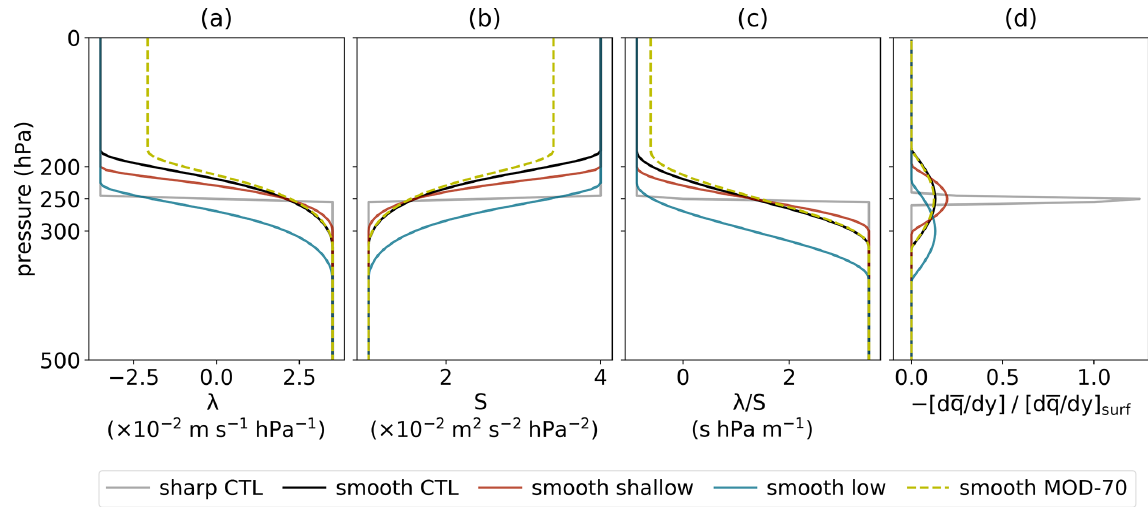
Figure 1. Vertical profiles of λ , S , λ/S , and ∂q/∂y near the tropopause for the sharp and smooth control experiments (grey and black, respectively) contrasted with experiments featuring a smooth shallow tropopause with δ = 100hPa (red), a smooth low tropopause with p ∗ = 300hPa (blue), and a reduction of stratospheric wind shear divided by stratification to 70% of the original value, i.e. ˆ α = 0 . 7